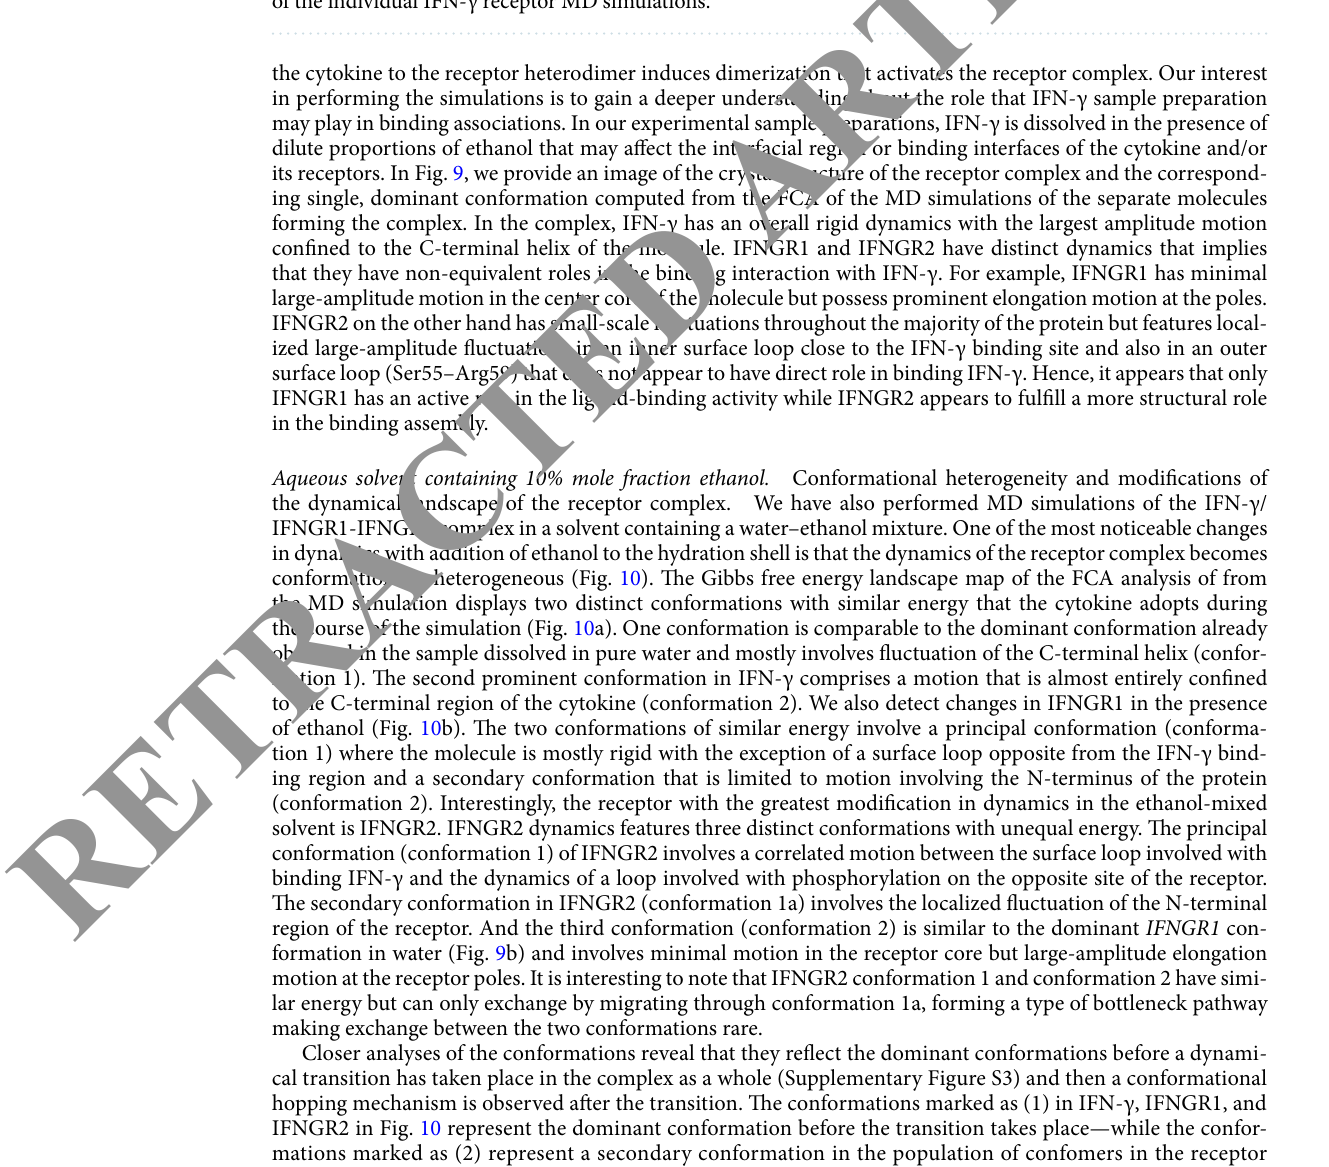
Figure 9. ( a ) 3-D representation of the structure of the IFN - γ receptor complex and ( b ) the dynamics of the principal conformational states of the individual components forming the receptor complex from the FCA of all of the individual IFN - γ receptor MD